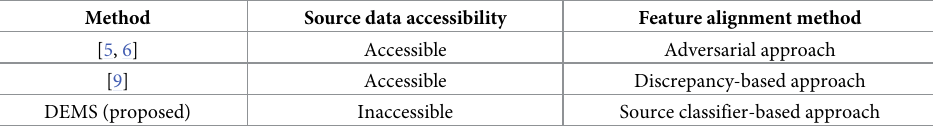
Table 3. Comparison of different latent space transformation methods for unsupervised multi-source domain adaptation